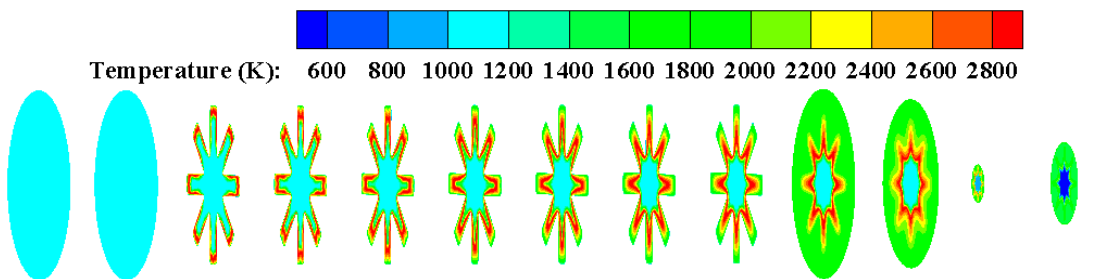
Figure 13. Temperature distribution in the motor for case no-seg.